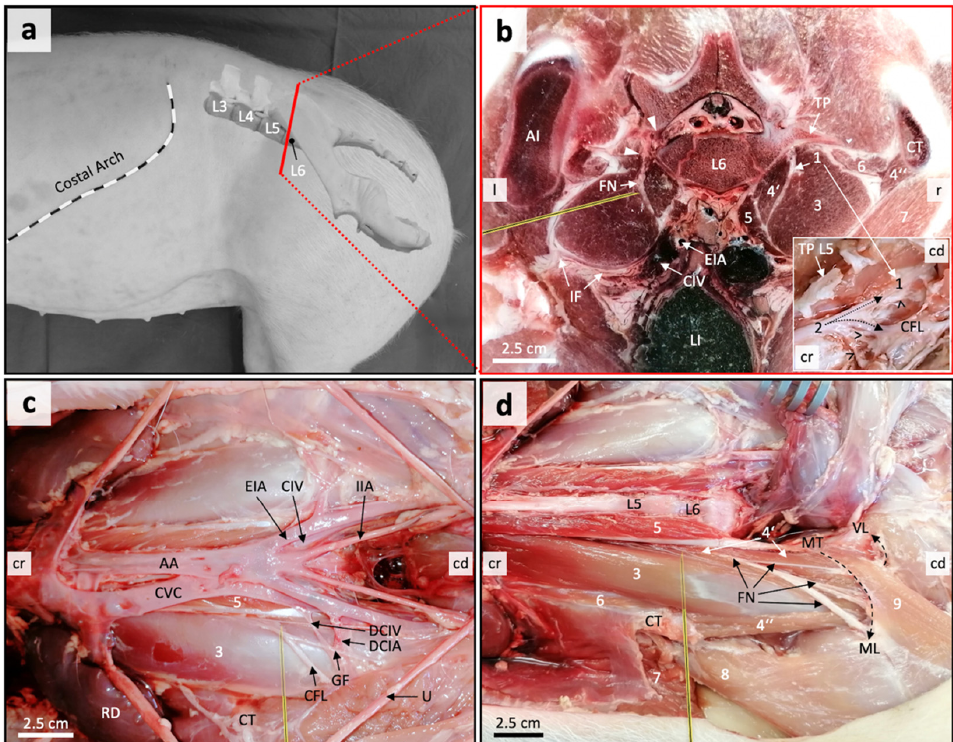
Figure 2. Gross anatomical dissection of the proximal femoral nerve (FN) and adjacent musculoskeletal and neurovascular structures. The proposed position and direction for needle insertion is shown in yellow. ( a ) Left lateral view showing the assumed section plane of the transverse frozen section in b; L3–L6, third to sixth lumbar vertebrae. ( b ) Slightly oblique transverse frozen section, caudal view. Left side (l) showing the ala of ilium (AI) and fifth lumbar nerve (arrowheads), which is the main segmental nerve supplying the FN. Right side (r) showing the coxal tuber (CT) and caudal directed plexus branch (1; insert: 1) of the fourth lumbar nerve (insert: 2) to supply the FN. The insert shows a ventrolateral view on nerve structures after removal of the psoas major muscle at the level of L5 to L6 using a fresh cadaver. TP L5, transverse process of L5; muscular nerve branches (open arrowheads); CFL, cutaneous femoris lateralis nerve; cr, cranial; cd, caudal. Further structures of the transverse section: EIA, external iliac artery; CIV, common iliac vein; IF, iliac fascia; LI, large intestine; 3 = psoas major muscle; 4 = iliac muscle, 4 ′ = its medial and 4 ″ = its lateral part; 5 = psoas minor muscle with its prominent insertion tendon; 6 = quadratus lumborum muscle; 7 = abdominal wall muscles (yellow line). ( c ) Ventral view of relevant hypaxial structures at the level of the iliopsoas compartment after removal of transversal and iliac fascia elements and fat using a fresh cadaver. AA, abdominal aorta; CVC, caudal vena cava; IIA, internal iliac artery; DCIA, deep circumflex iliac artery; DCIV, deep circumflex iliac vein; GF, genitofemoral nerve; RD, ren dexter; U, ureter. The numbering applies as in b. ( d ) Ventral view on the FN and its branching pattern after removal of vascular structures. MT, muscular tubercle of psoas minor and sartorius muscle; ML, muscular lacuna; VL, vascular lacuna; 8 = tensor fasciae latae muscle; 9 = sartorius muscle. The remaining numbering applies as in b.